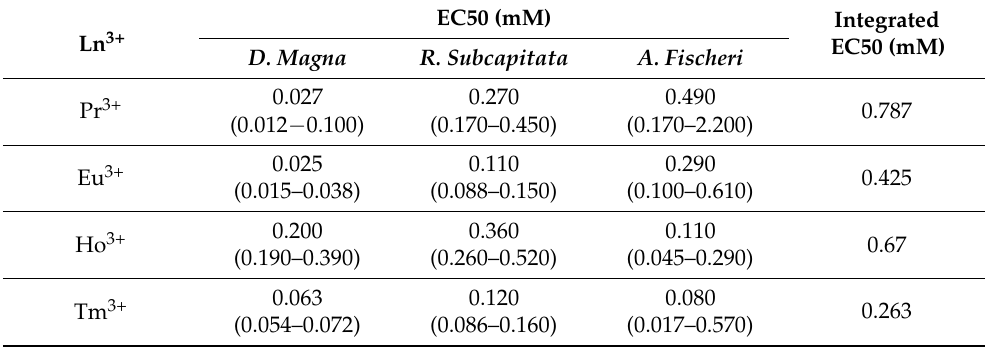
Table 4. Median effective concentration (EC50) of praseodymium, europium, holmium, and thulium for D. magna (acute immobility test), R. subcapitata (chronic algal growth inhibition test), and A.